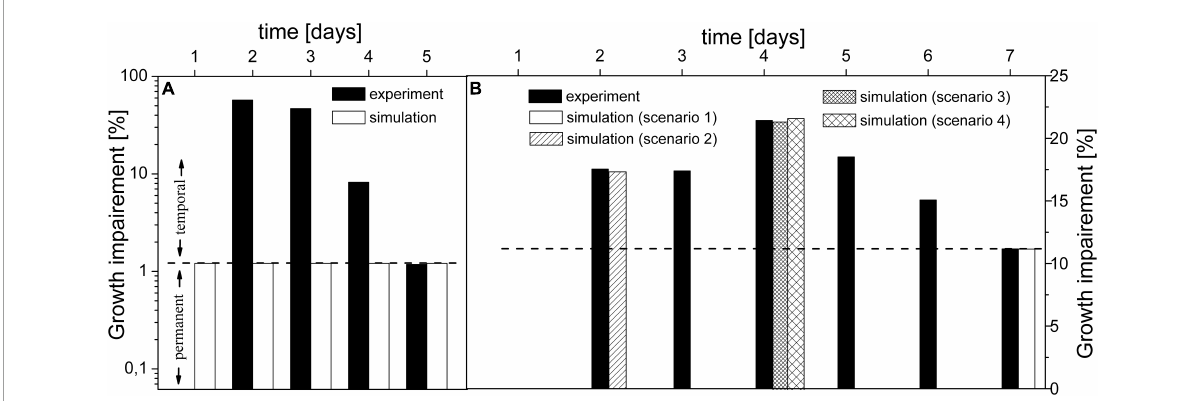
FIGURE3 Comparison of experimental and simulated growth impairment caused by (cid:49) eda under mixotrophic (A) and autotrophic (B) conditions. Original experimental growth data (Makowka et al., 2020) for WT and (cid:49) eda were normalized to illustrate the growth impairment. Dashed line designates the possible division between the temporal and permanent components of growth impairment. Part (A) shows results for mixotrophic conditions (experimental data point for day 1 is not visible as it equals 0). Part (B) shows results for autotrophic conditions and elaboration of tested scenarios: 1 – flux via ED-P estimated to fit experimental growth impairment, assumed higher decarboxylation and KDPG accumulation from the previous days; 2 – initial usage of intracellular glycogen; 3 – 100% up-regulation of gnd and 4 – increased accumulation followed by excretion of